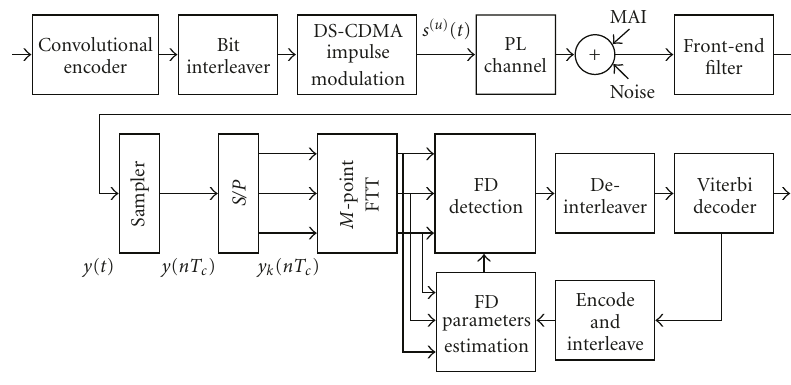
Figure 1: Impulse-modulated PL system with frequency-domain receiver processing and iterative